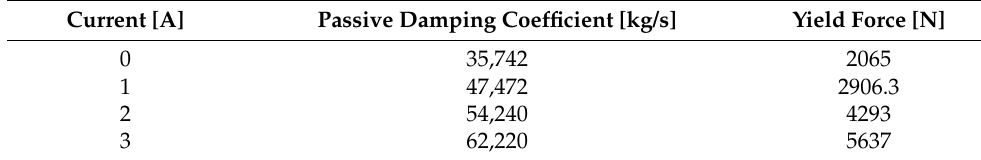
Figure 8. Damping force vs. velocity curves of simplified and HBM models in radial channel. Table 2. Model parameters values in the radial channel at different currents.